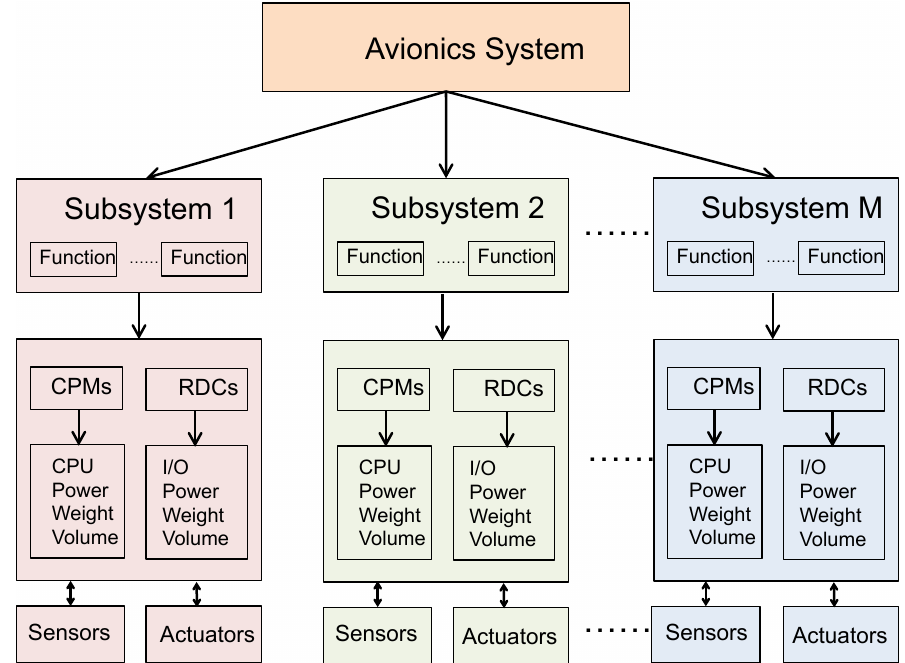
Figure 2. The structure of system layer in DIMA. The system layer contains multiple subsystems